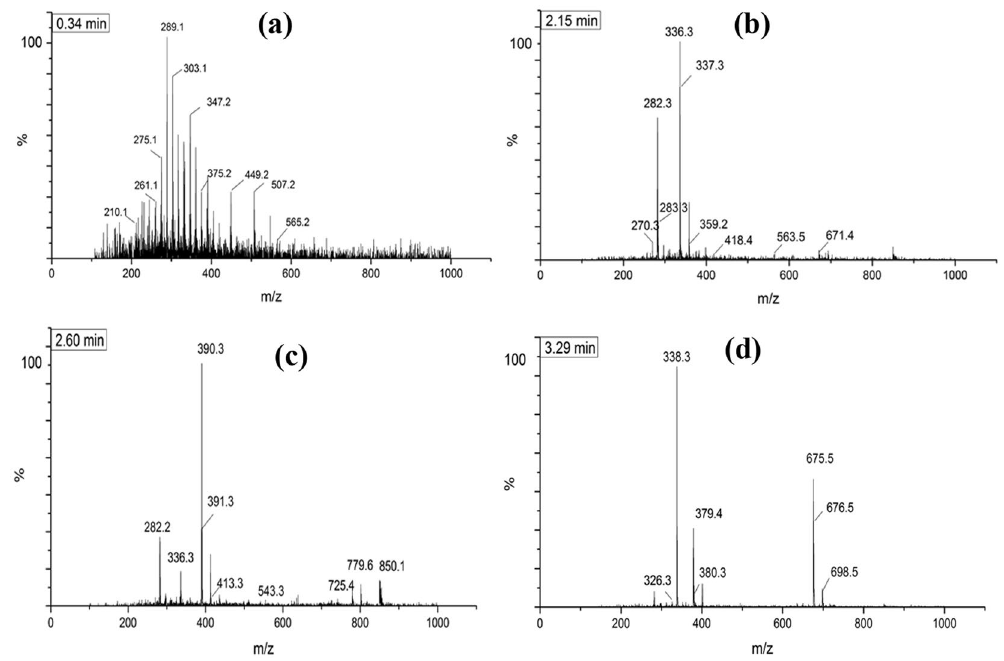
Figure 11. The mass spectra of p -xylene decompressed from 25 GPa to ambient